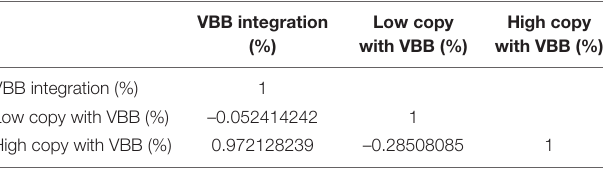
TABLE 4 | Correlation coefficients for events with VBB presence and transgene copy